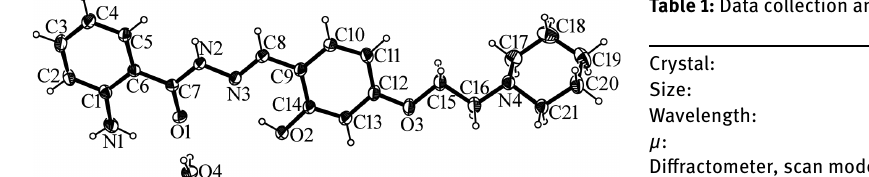
Table 1: Data collection and handling.